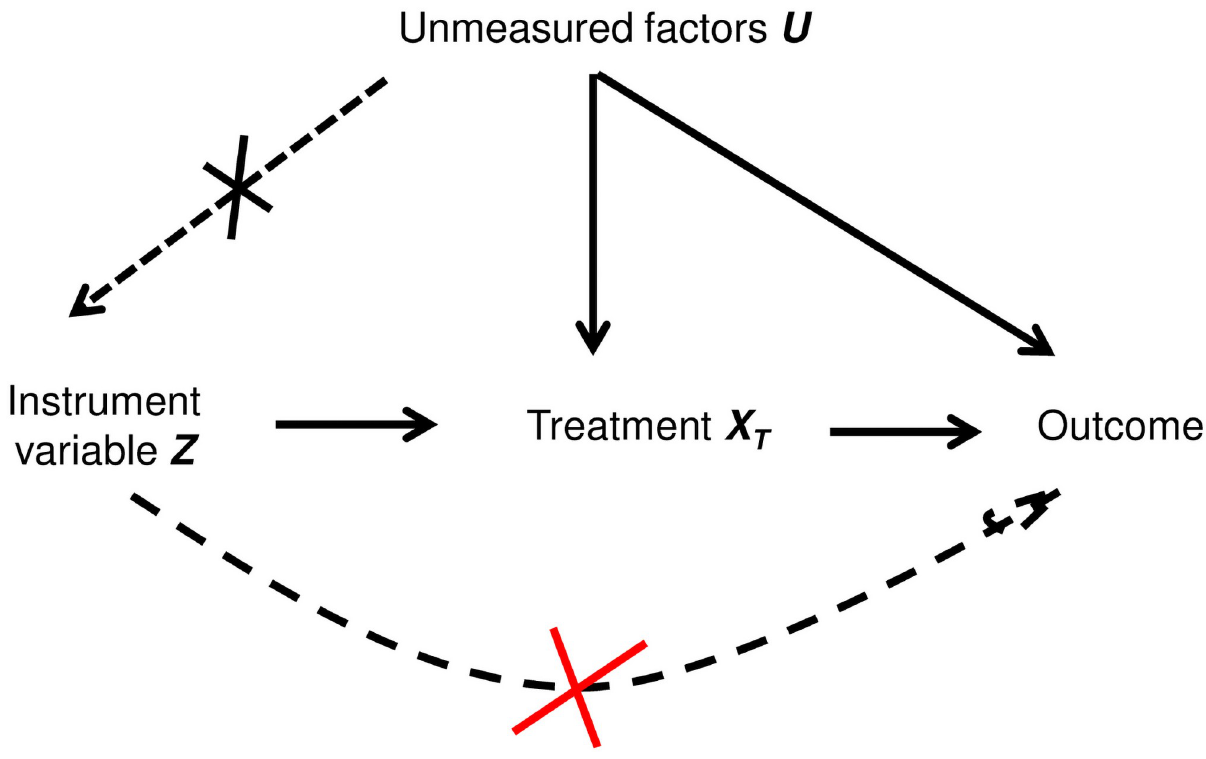
Fig 1. Assumptions of Instrument